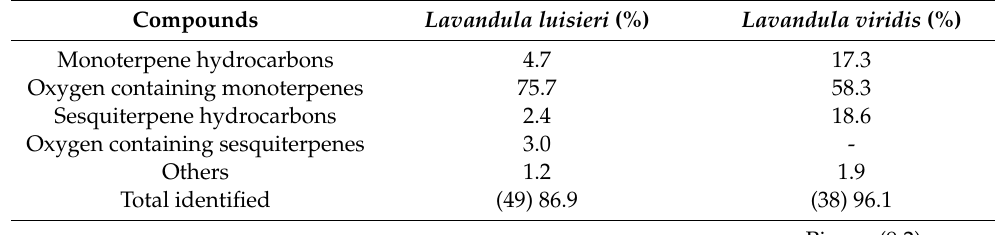
Table 1. Major composition of Lavandula luisieri and Lavandula viridis essential oils.